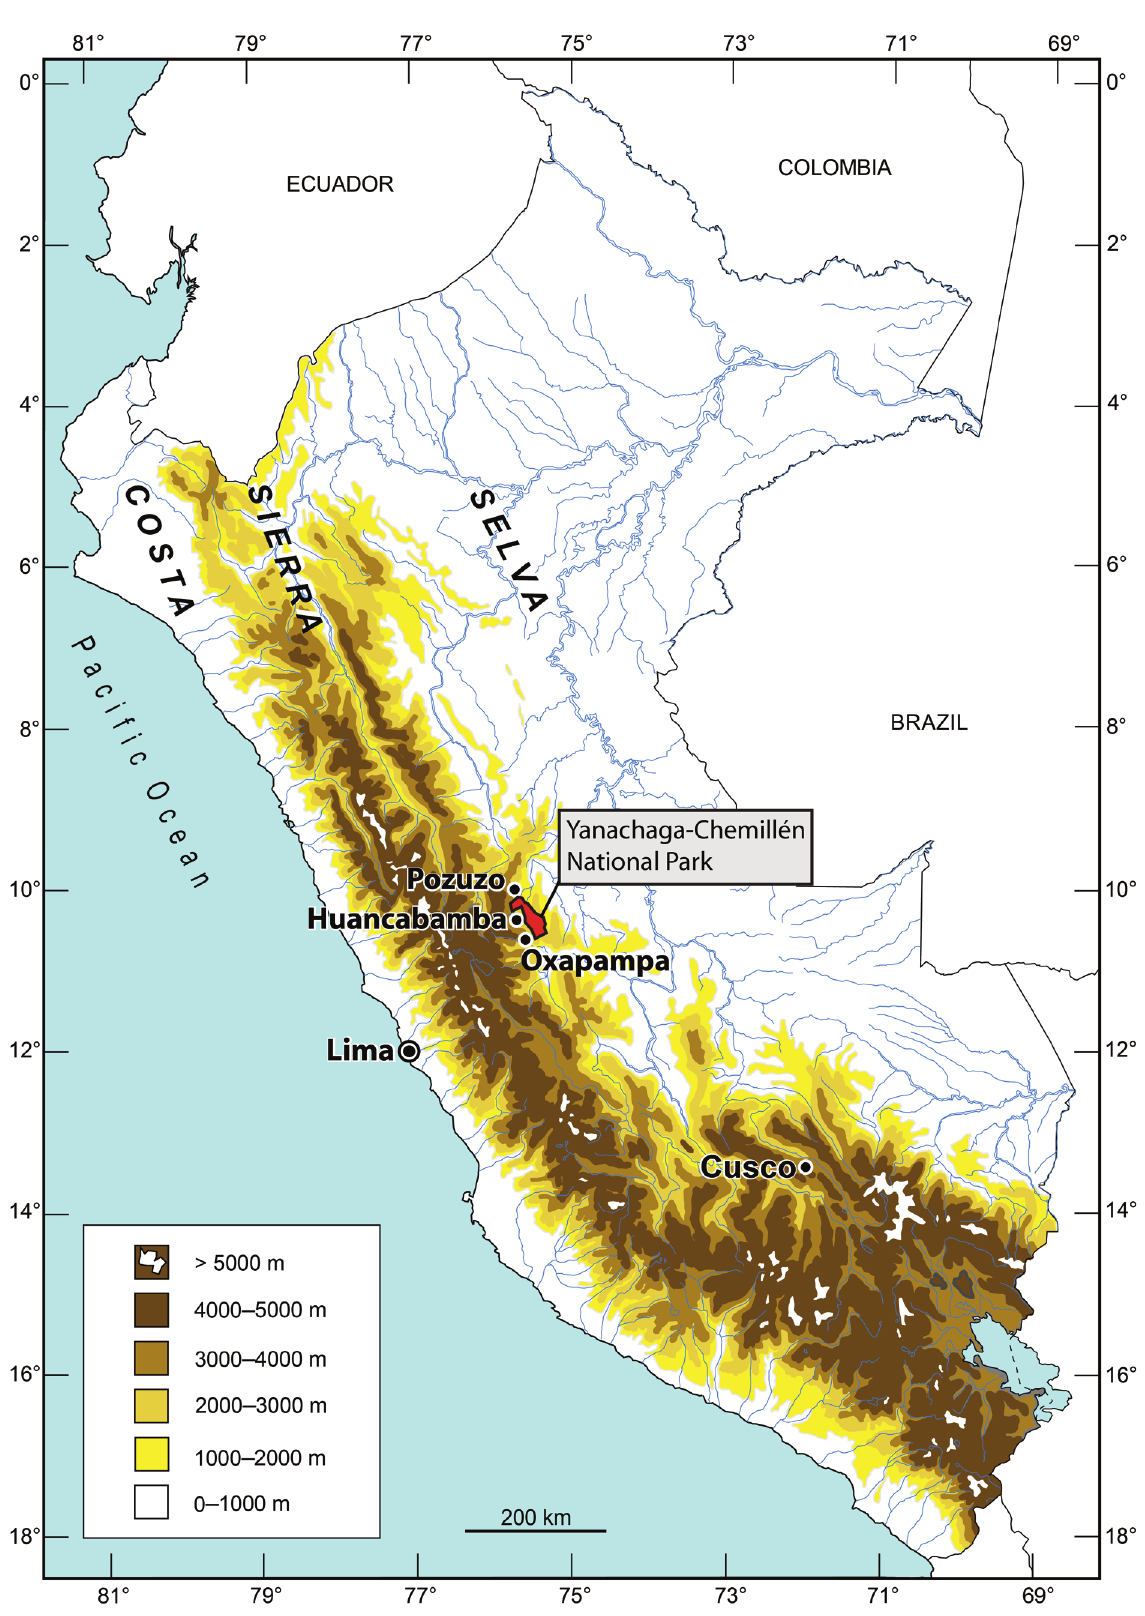
Fig. 1. Map of Peru with the Yanachaga-Chemillén National Park indicated in